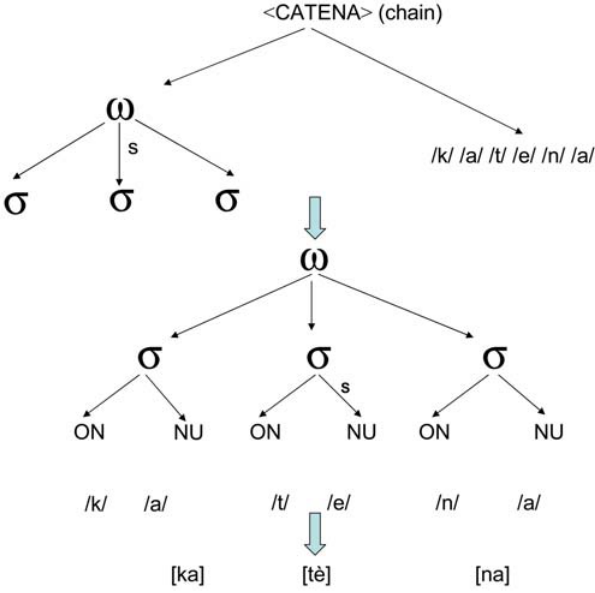
Figure 1. Schematic representation of the metrical represen- tation of stress, and how it connects with the segmental representation during phonological encoding.